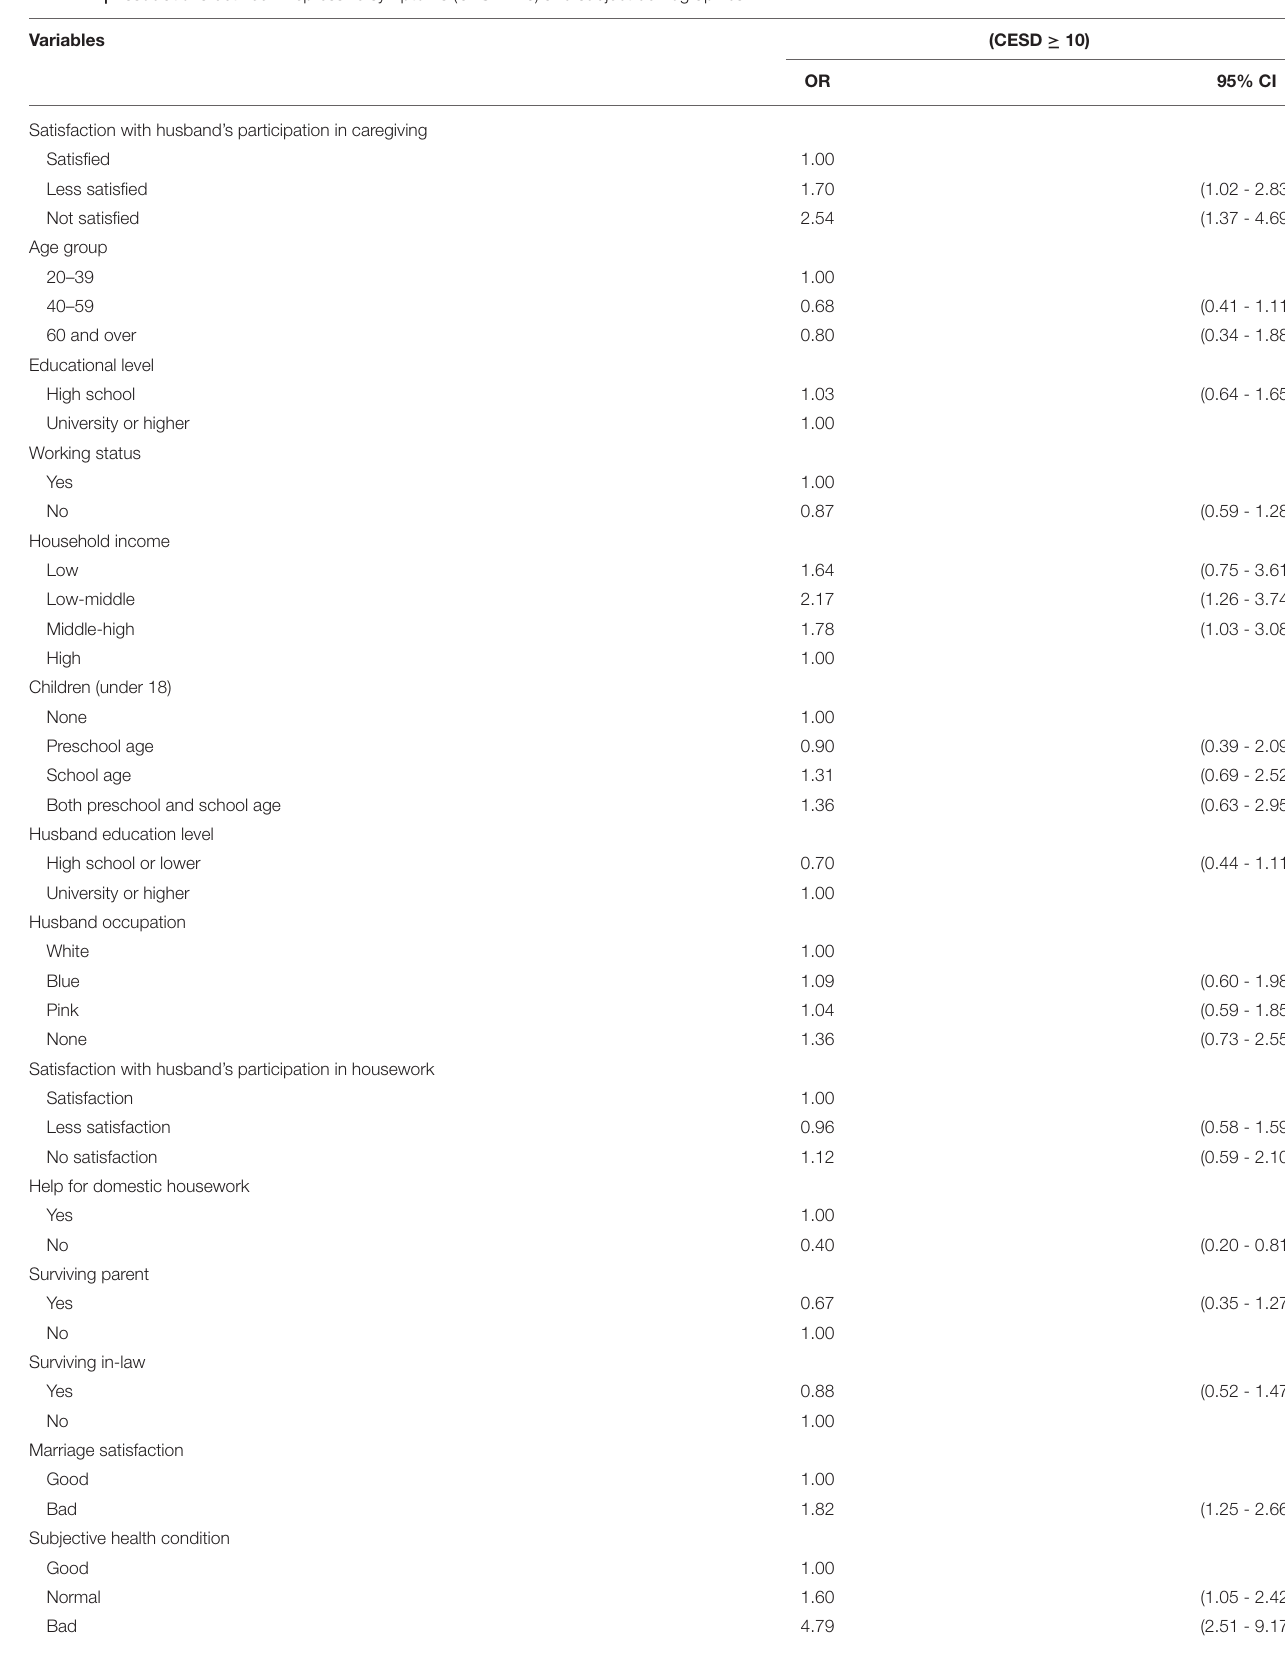
TABLE 2 | Associations between Depressive symptoms (CES-D-10) and subject demographics. Variables (CESD ≥ 10)